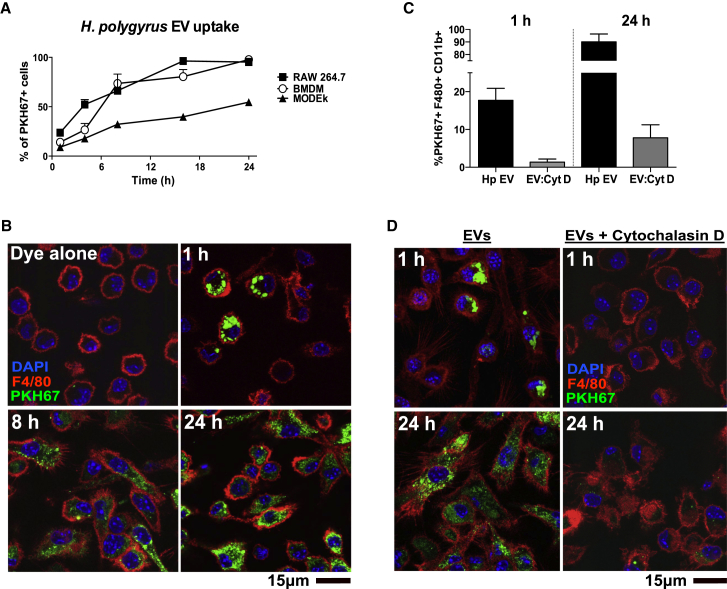
H. polygyrus EVs Are Efficiently Taken up by Bone Marrow-Derived Macrophages in a Cytochalasin D-Sensitive Manner(A) Percentage uptake of 2.5 μg PKH67-labeled EVs incubated with 2.5 × 105 BMDMs, RAW264.7, or MODE-K cells from 1 to 24 hr, as assessed by flow cytometry using the gating strategy in Figure S1A. Data are presented as mean values ± SD (n = 3).(B) Confocal microscopy image of PKH67-labeled EVs incubated with BMDMs from 1 to 24 hr. DAPI is used to stain nuclei and F4/80-Alexa Fluor-647 to label macrophages.(C) Percentage uptake of 2.5 μg PKH67-labeled EVs (Hp EVs) after 1 or 24 hr in the absence or presence of 4 hr pre-treatment of BMDMs with 2 μg/mL cytochalasin D, as assessed by flow cytometry. Data are presented as mean values ± SD (n = 5).(D) Confocal microscopy image of the cells treated as in (C) using the fluorescent markers described for (B). For (B) and (D), scale bars represent 15 μm, with representative images shown.